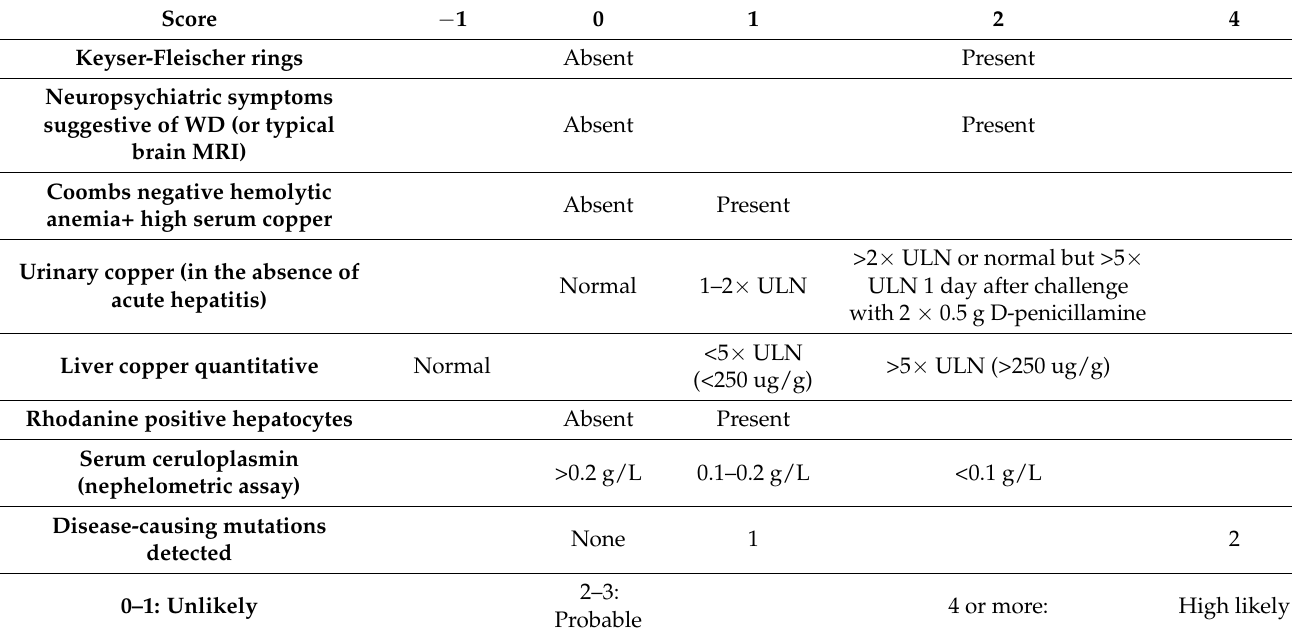
Table 2. The diagnostic score for Wilson’s disease. Modified after the consensus agreement [12].